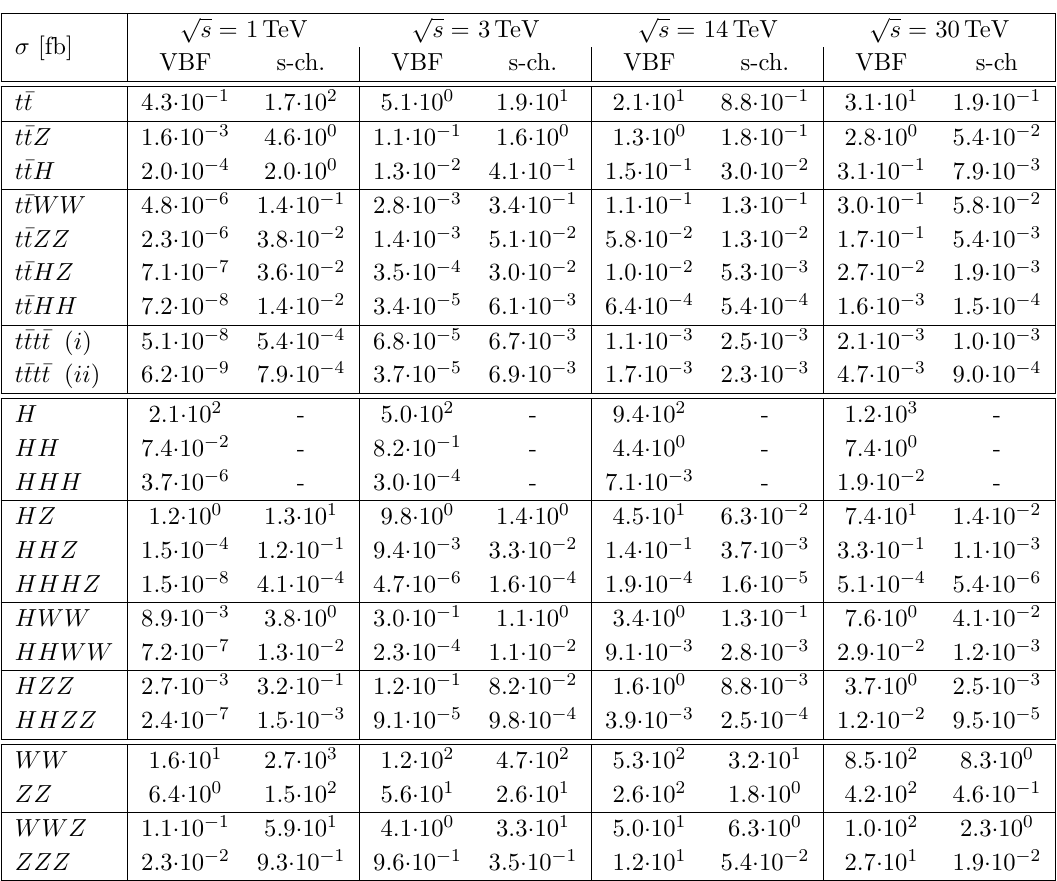
Table 1 . Same as (cid:12)gures 3 and 4 but tabulated for representative collider energies. For the tttt